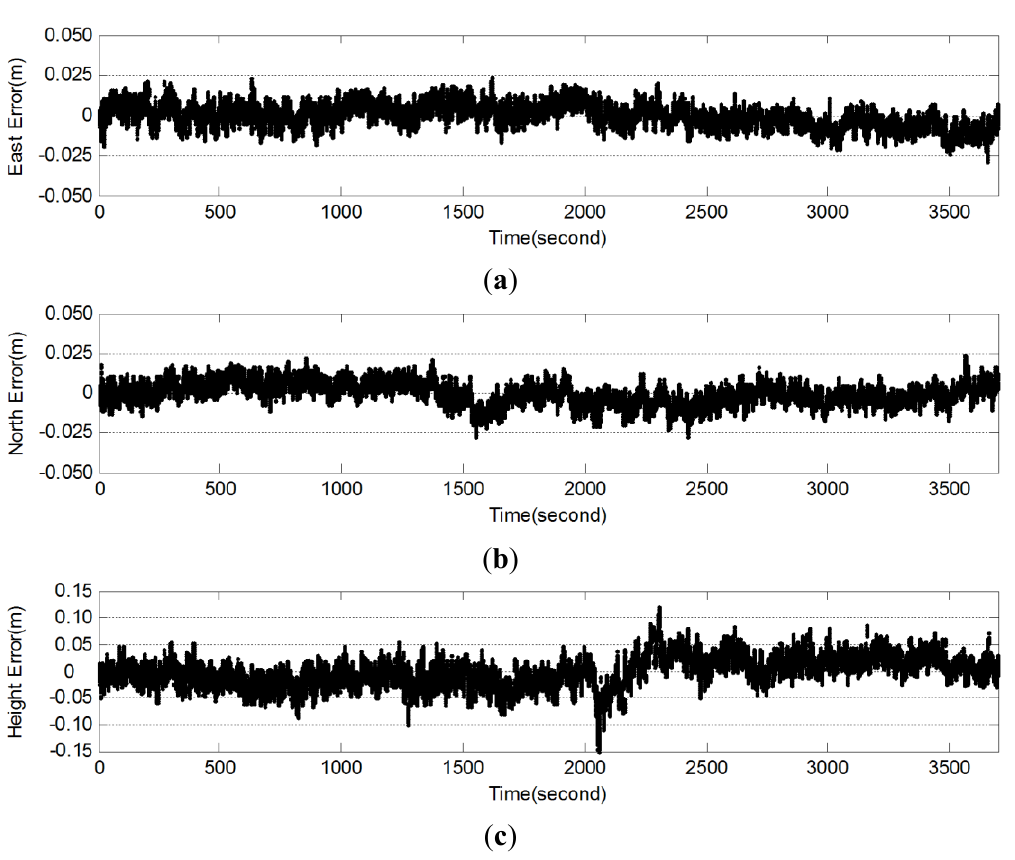
Figure 5. A sample of test results (at Point 1 ) for evaluating the positioning. ( a ) Positioning errors of north coordinates. ( b ) Positioning errors of east coordinates. ( c ) Positioning errors of ellipsoid heights.